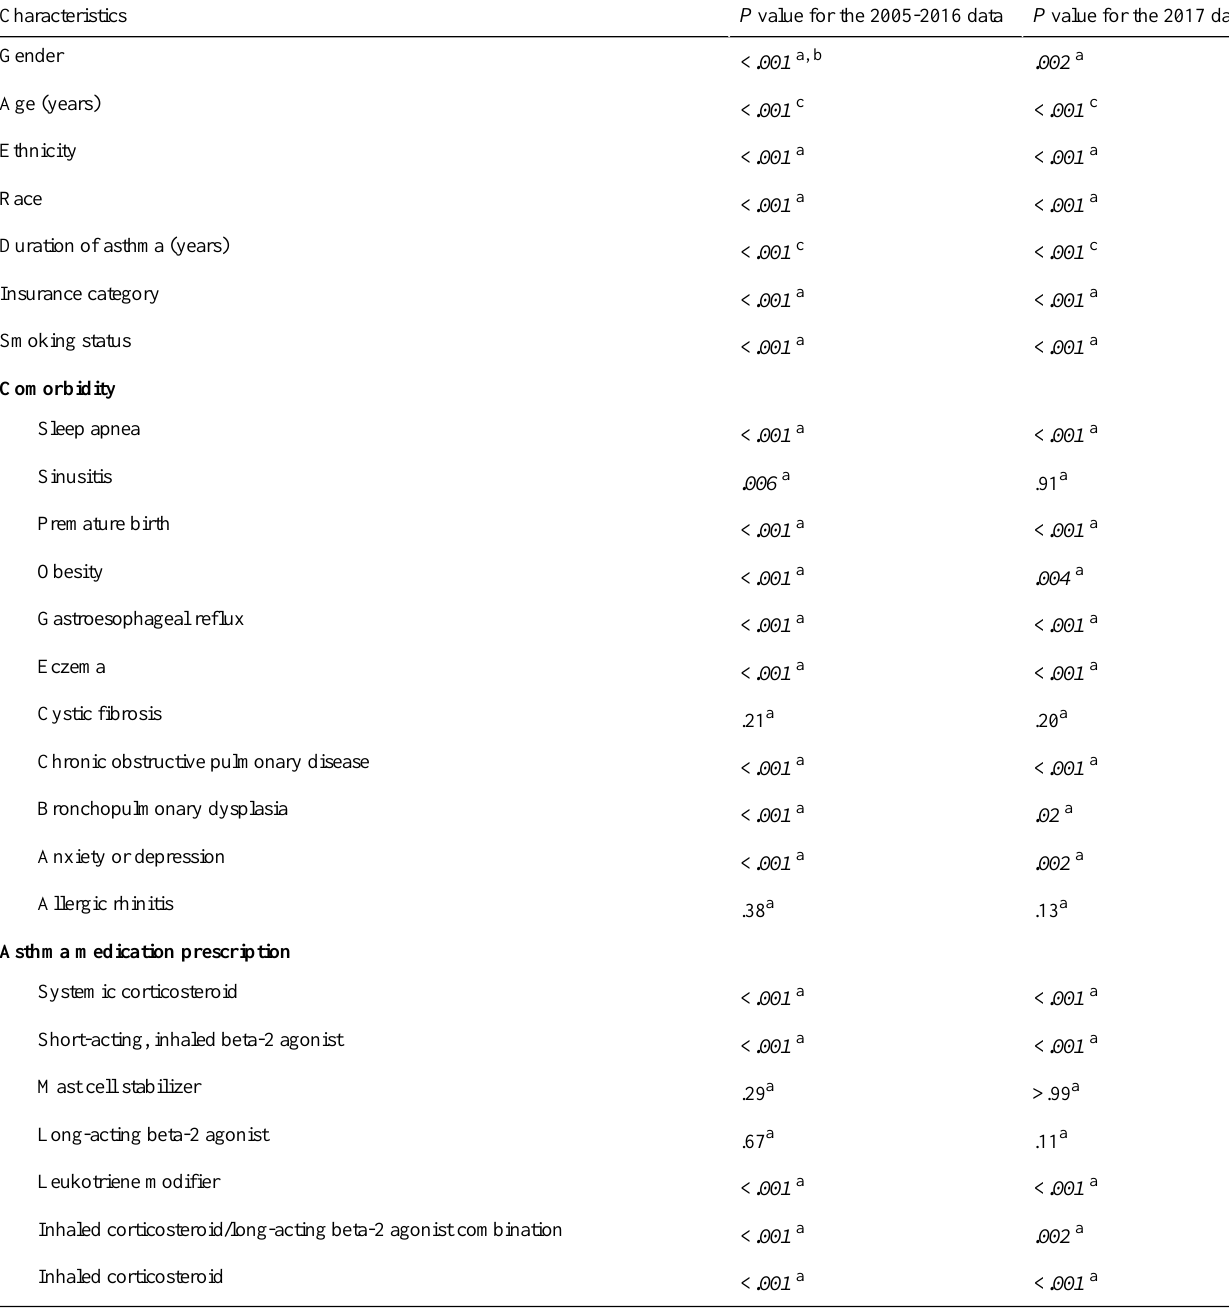
Table 3. For each demographic or clinical characteristic, the statistical test results on whether the data instances related to asthma hospital visits in the subsequent year and those related to no asthma hospital visit in the subsequent year had the same distribution.